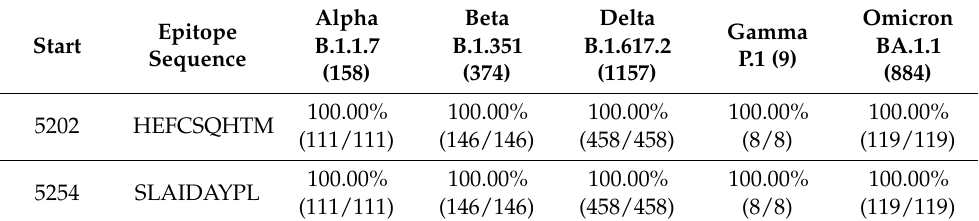
Table 6. Conservancy analysis of conserved epitopes in SARS-CoV-2 reference sequence against SARS-CoV-2 currently circulating VOCs of delta and omicron variants.